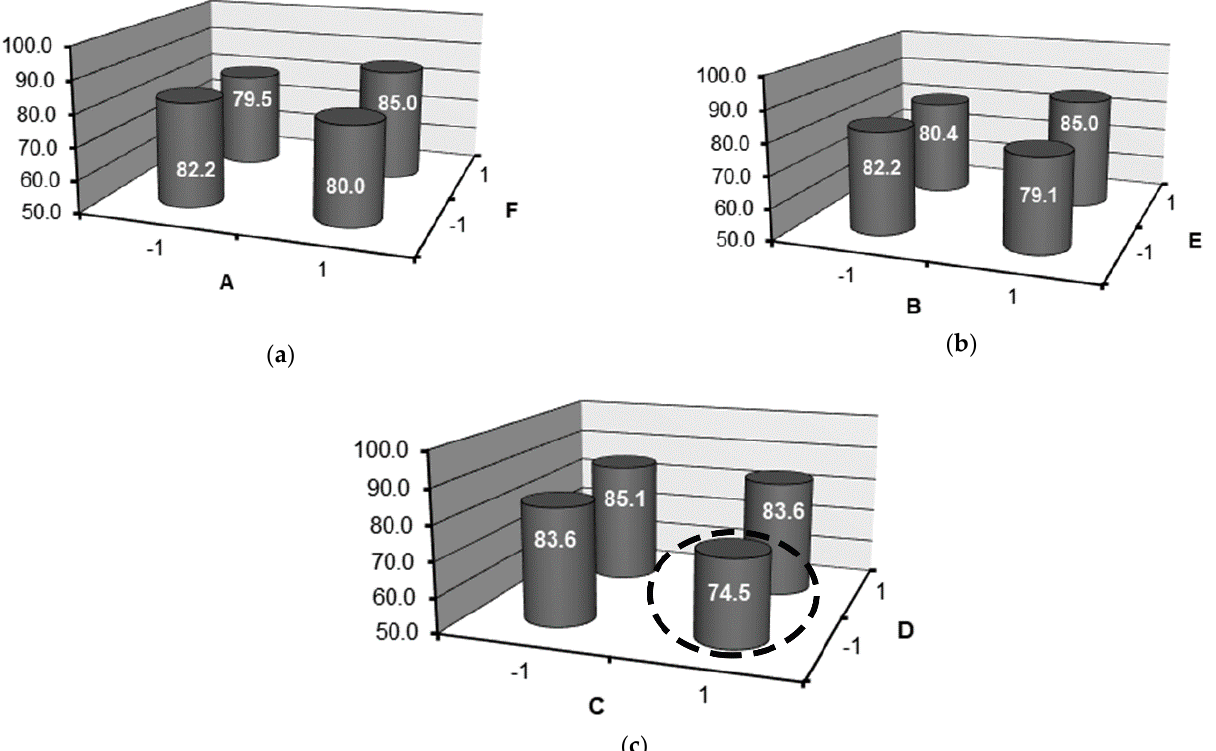
Figure 3. Analysis of the interactions AF + BE + CD. ( a ) interaction AF; ( b ) interaction BE; ( c ) interaction CD.